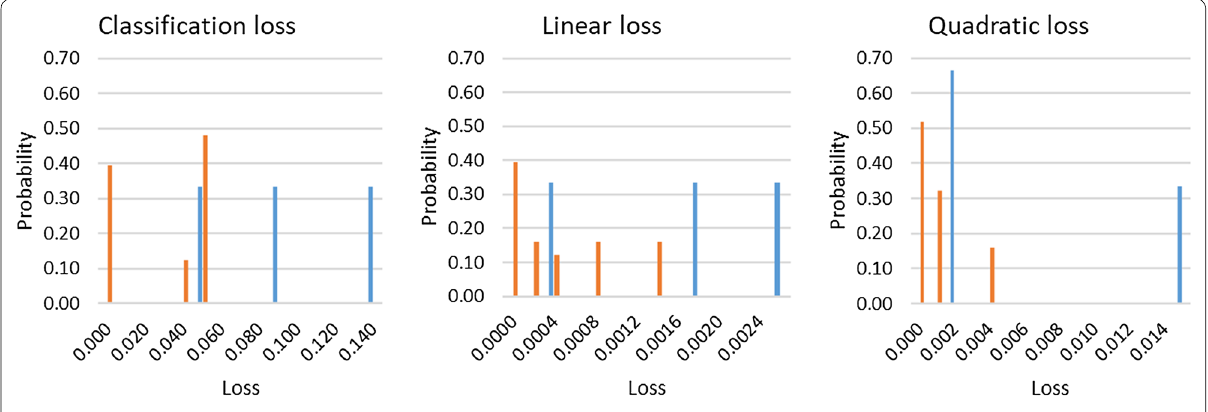
Fig. 2 Probability mass function of loss results. Probability mass function of loss results for enumeration input both for “Research on risks” in blue and “Research on benefits” in orange are reported for the classification, linear and quadratic loss functions. Because of the different natures of the quadratic loss function (i.e., error based vs value based), it is not meaningful to compare its absolute values with others, nevertheless the comparison is still sound in terms of comparing the patterns of the two sources of information along the different loss functions as well as relative comparisons inside single functions